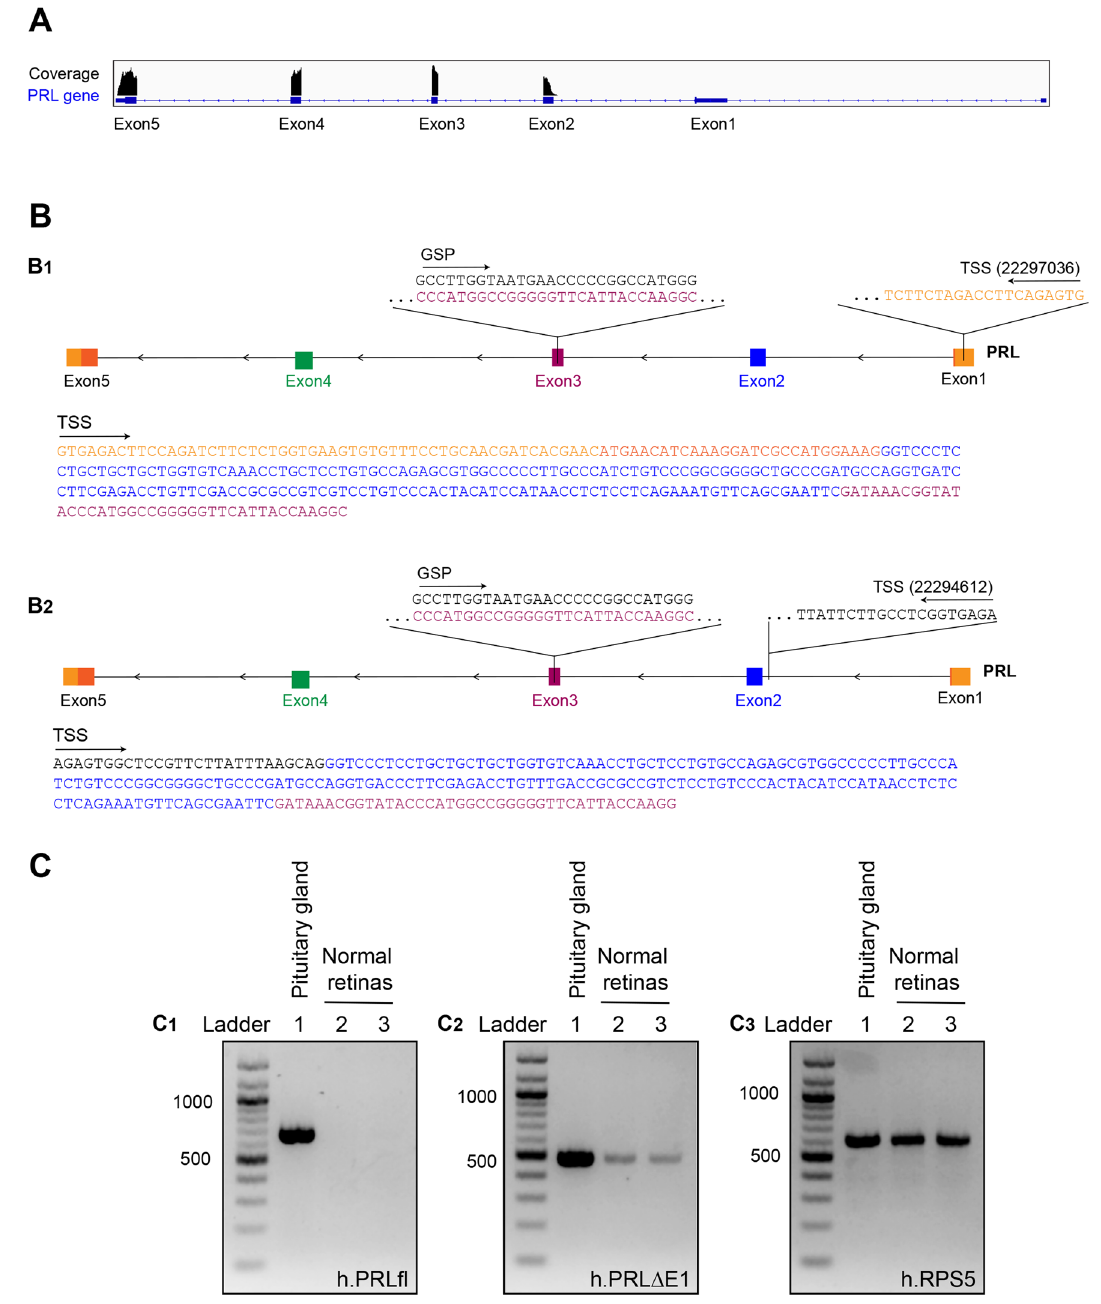
Figure 6. A short Prolactin isoform lacking exon 1 is expressed in the human retina. (A) Representative graph derived from Integrated Genomic View (IGV) showing RNAseq (GSE99248) 40 reads mapped by STAR for PRL exons expressed in retinas of normal human eyes. The annotated 6 exons present in the reference are shown, however, only exons 2, 3, 4 and 5 show any coverage. No reads were detected mapping to exon 1a and 1b. ( B) Transcription start site (TSS) for human pituitary (B1) and retinal (n = 3) (B2) PRL identified by 5 ′ -RACE. GSP = gene-specific primer. (C) The full length PRL (h.PRLfl) transcript is found in human pituitary gland (n = 1) but not in normal human retinas (n = 2) (C1) , whereas the short PRL isoform ( h.PRLΔE1 ) is expressed in human retinas (C2) . Amplification of housekeeping gene h.RPS5 was included as a control (C3)